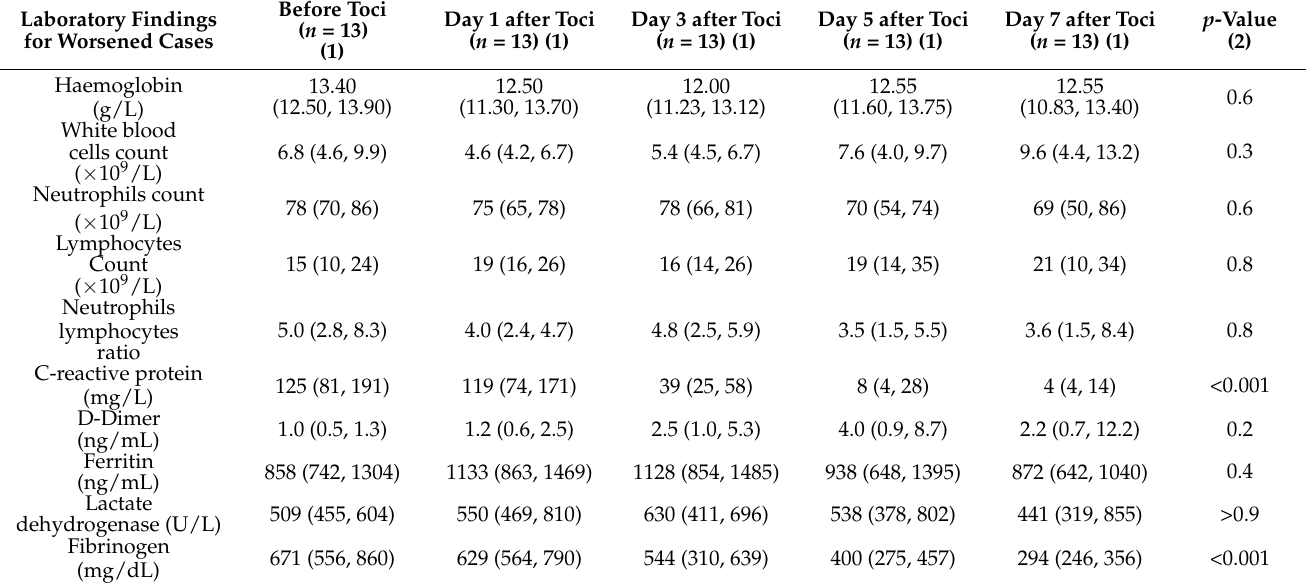
Table 5. Laboratory findings before and during Tocilizumab therapy among worsened